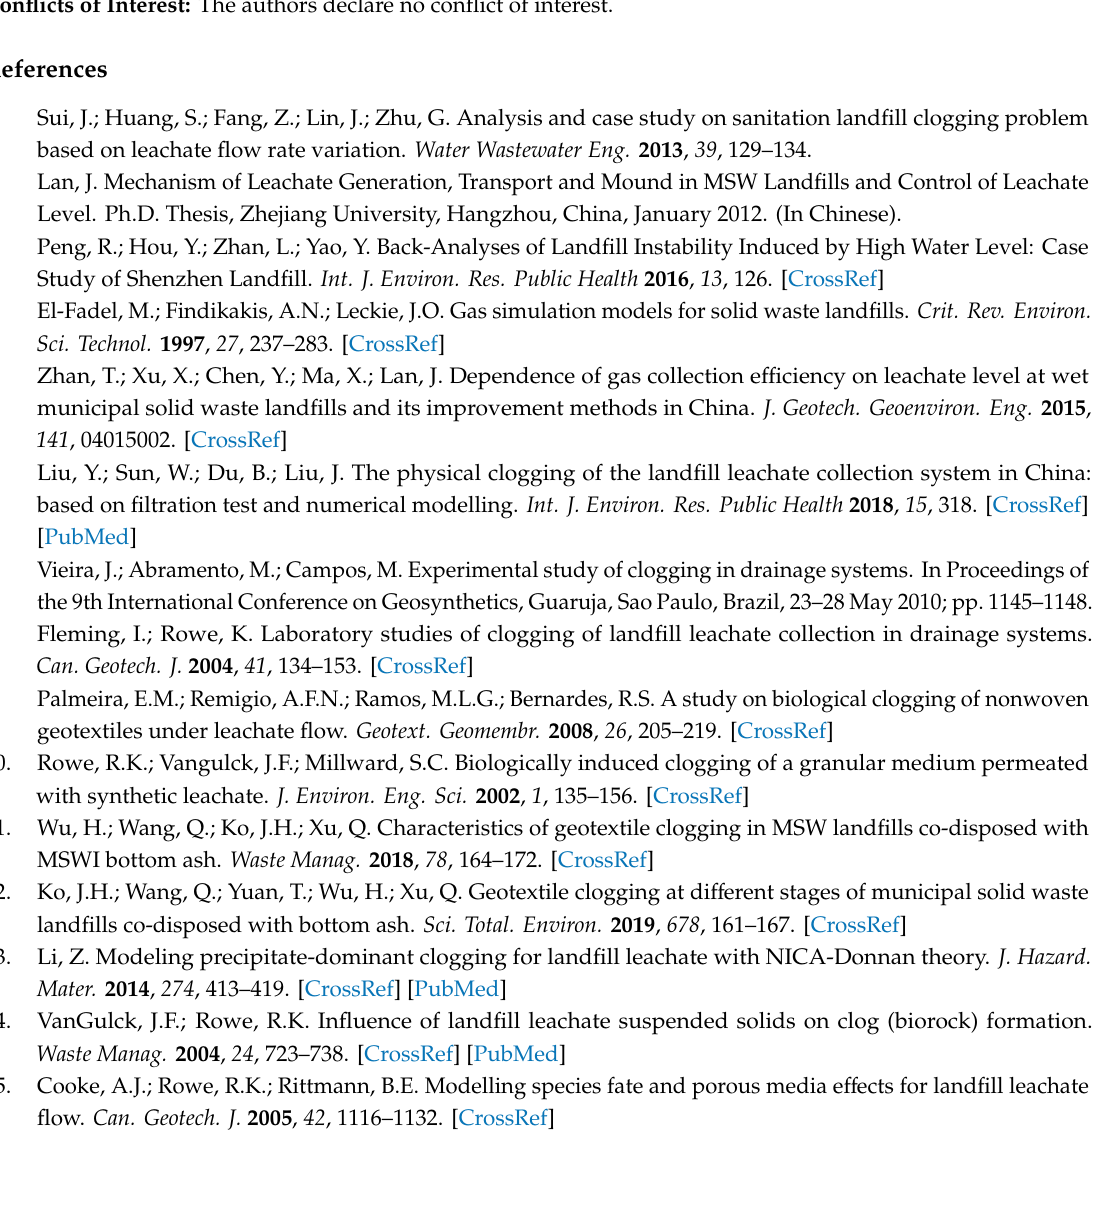
Figure S1: Cross-sectional diagram of the leachate collection system, Figure S2. Photo of experimental columns operation, Figure S3. The organic–inorganic sediments content in di ff erent parts of experimental columns, Table S1. Elements mass percentage of the inorganic precipitates, Table S2. Food waste proportion in di ff erent countries. Author Contributions: Conceptualization, Y.L. and J.L.; Data curation, Y.L.; Funding acquisition, Y.L. and J.L.; Investigation, Y.L.; Methodology, Y.L. and J.L.; Project administration, Y.L. and J.L.; Visualization, Y.L.; Writing—original draft, Y.L.; Writing—review and editing, J.L. All authors have read and agree to the published version of the